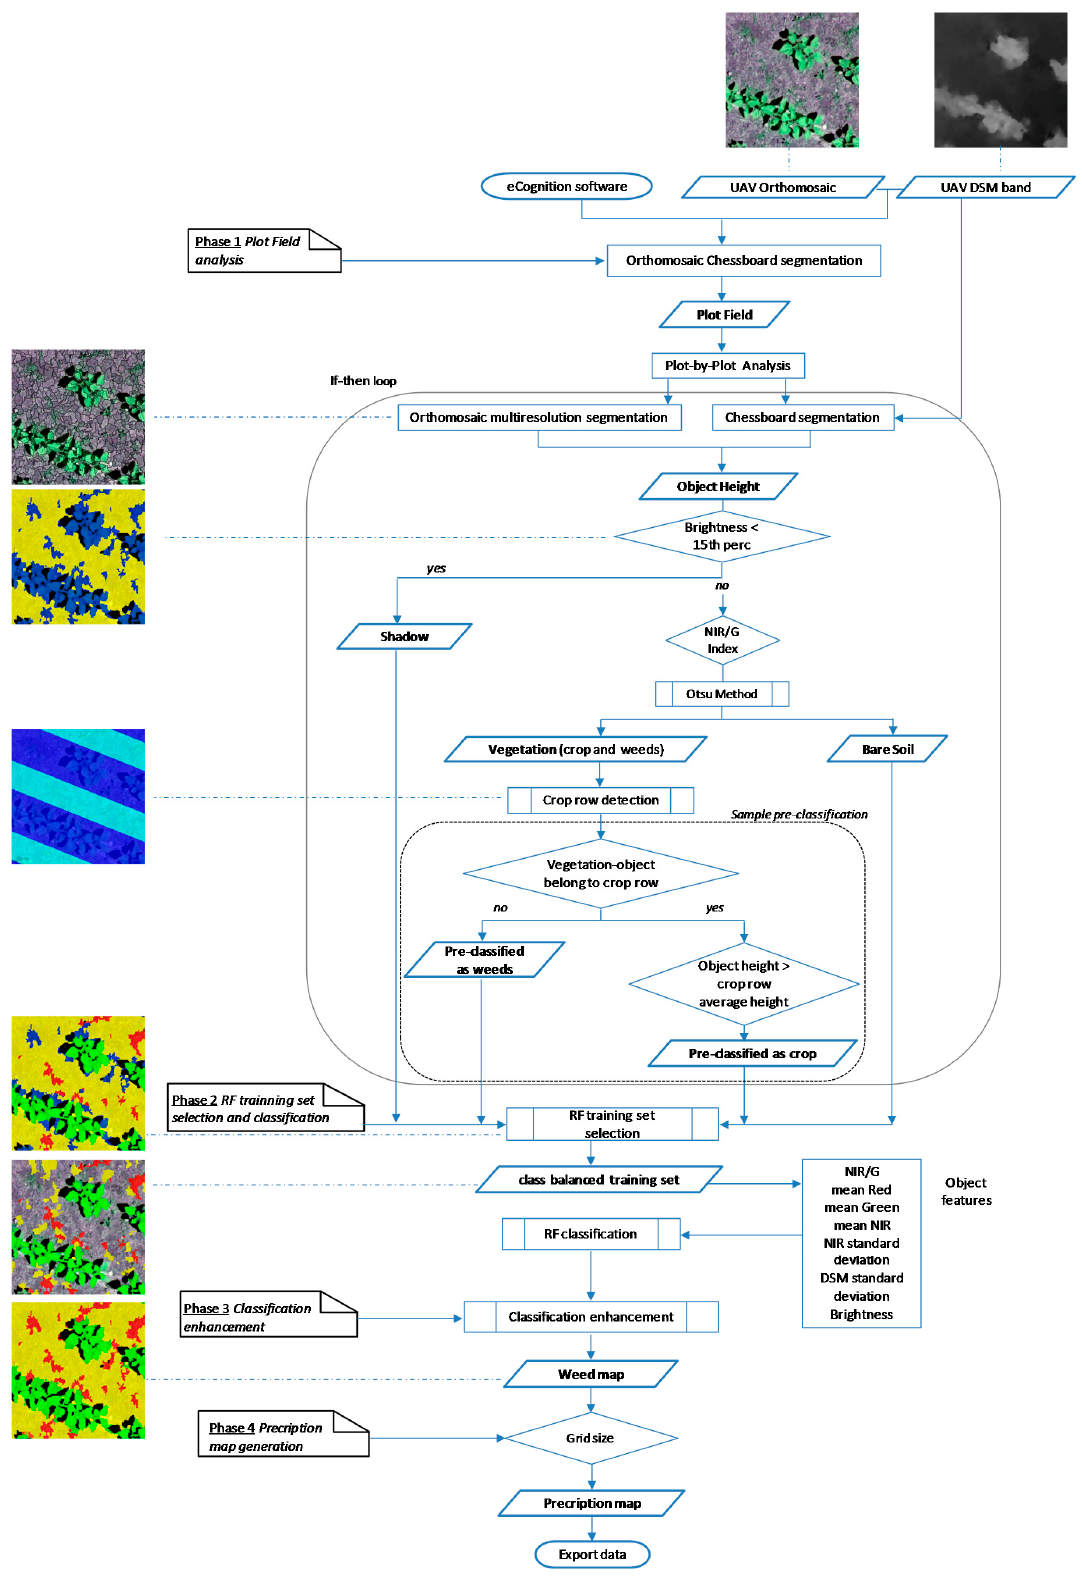
Figure 4. Flowchart and graphical examples of the Object Based Image Analysis (OBIA) procedure outputs for weed detection outside and within crop rows.